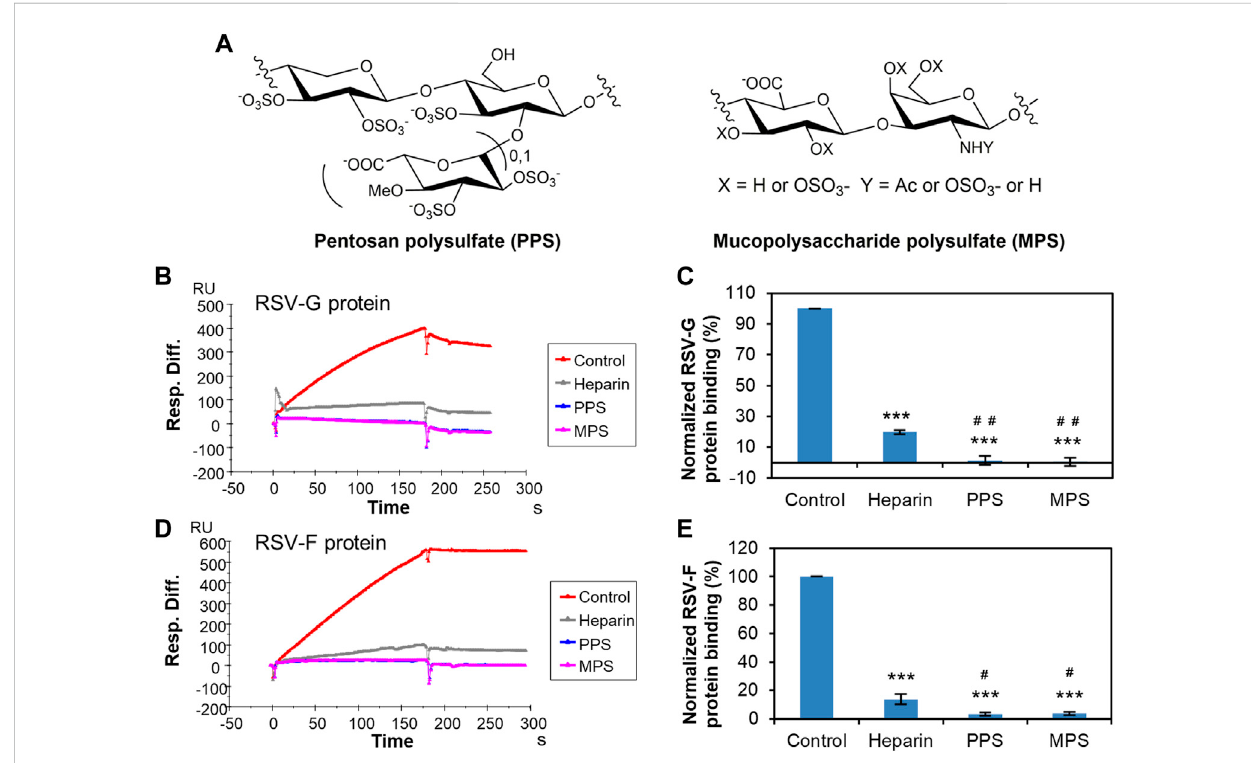
FIGURE 4 Solution competition between heparin and PPS or MPS. (A) Structure of PPS and MPS. (B) SPR sensorgrams of RSV-G protein – heparin interaction competing with PPS or MPS. Concentration of RSV-G protein is 250 nM mixed with 1,000 nM of PPS or MPS. (C) Bar graphs (based on triplicate experiments with standard deviation) of normalized RSV-G protein binding to surface-immobilized heparin by competing with PPS or MPS. (D) SPR sensorgrams of RSV-F protein – heparin interaction competing with PPS or MPS. Concentration of RSV-F protein is 40 nM mixed with 1,000 nM of PPSorMPS. (E) Bargraphs(basedontriplicateexperimentswithstandarddeviation)ofnormalizedRSV-Fproteinbindingtosurface-immobilizedheparin by competing with PPS or MPS. Statistical analysis was performed using unpaired two-tailed t -test (***: p ≤ 0.001 compared to the control, #: p